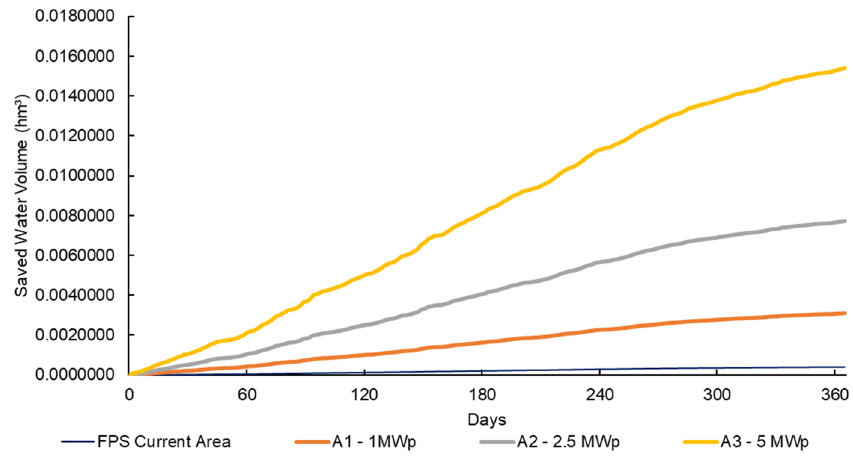
Figure 8. Accumulated saved water volume by the FPS for current and future coverage area ex-